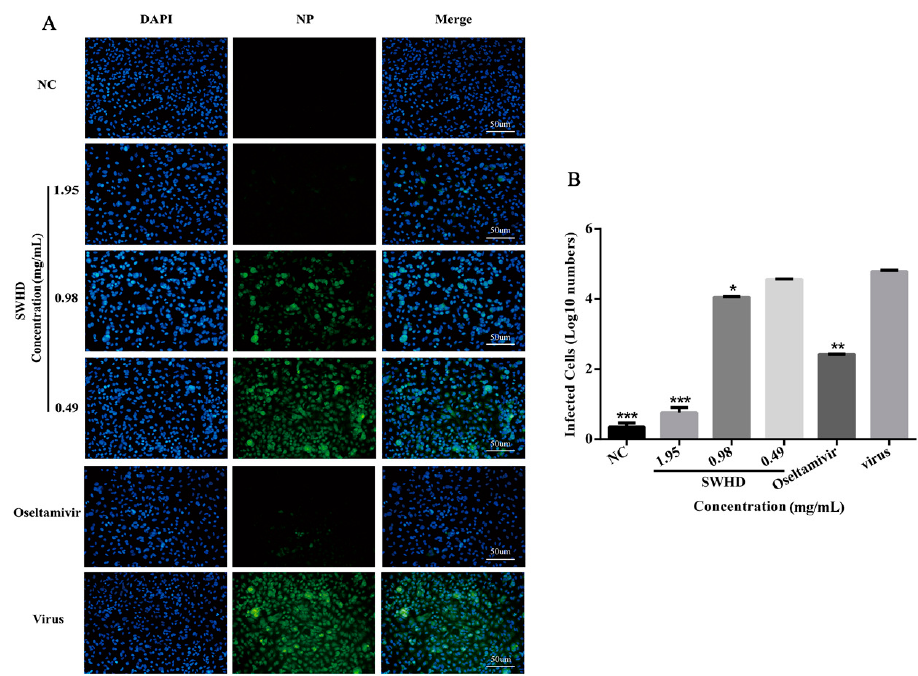
Figure 4. The immunofluorescence assay demonstrated the inhibition of the viral NP protein by SWHD were performed. Cells were then stained for NP (green) and cell nuclei were stained with DAPI (Diphenyl phenylindole) (blue). The scale bar in each panel represents 50 µ m ( A ). Images were obtained from one representative experiment of three independent experiments with similar results.